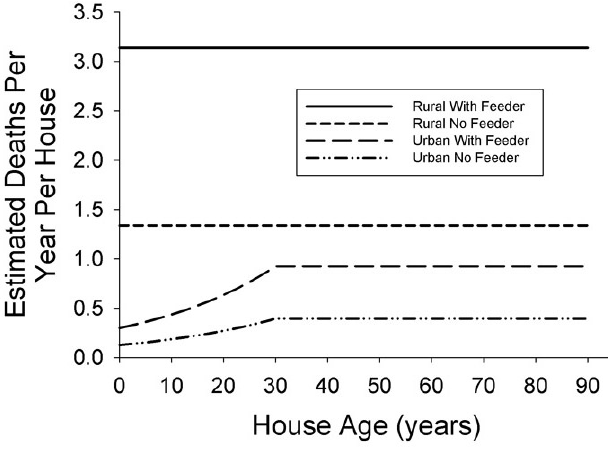
Fig. 1 . Relationships used to compute number of birds killed per house from Bayne et al. (2012). Age data were not available for rural dwellings, so static values were